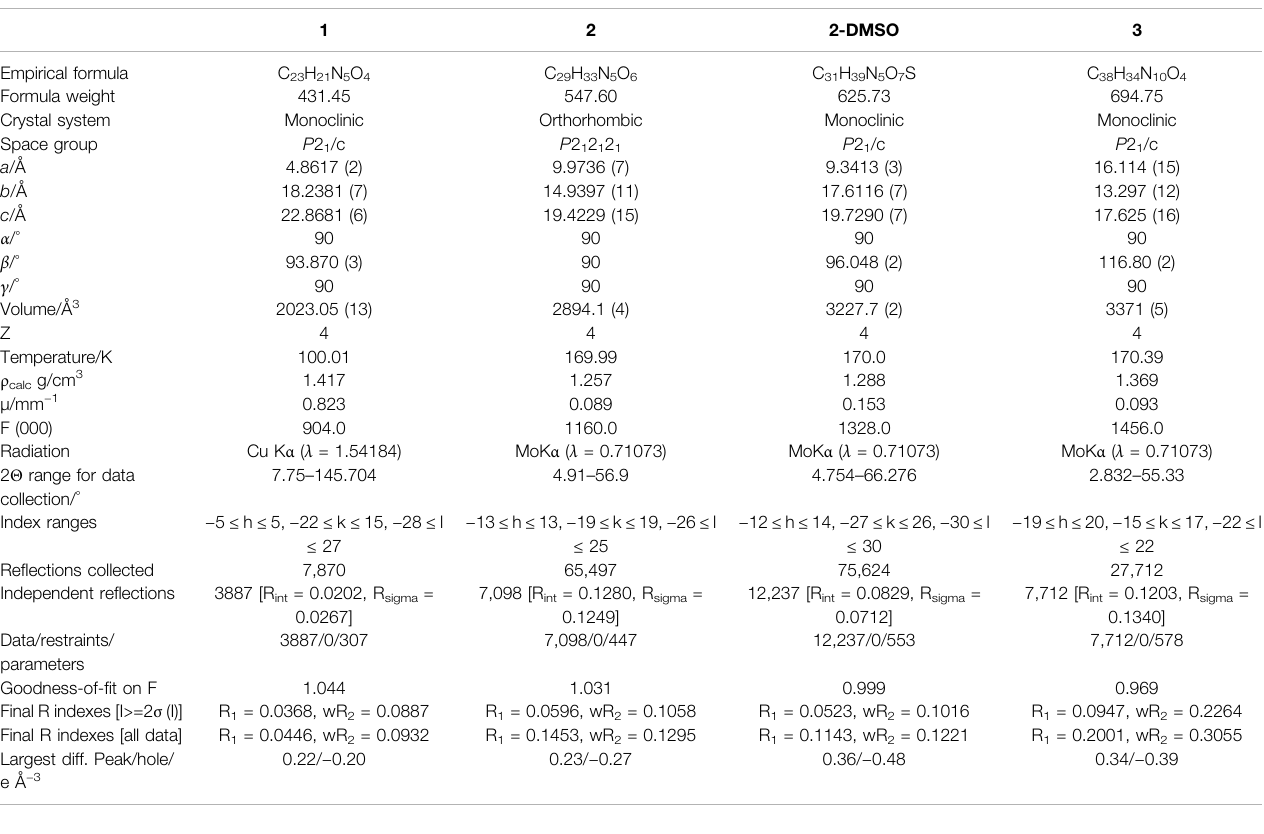
TABLE 1 | Selected crystallographic data for 1, 2, 2 -DMSO and 3 .